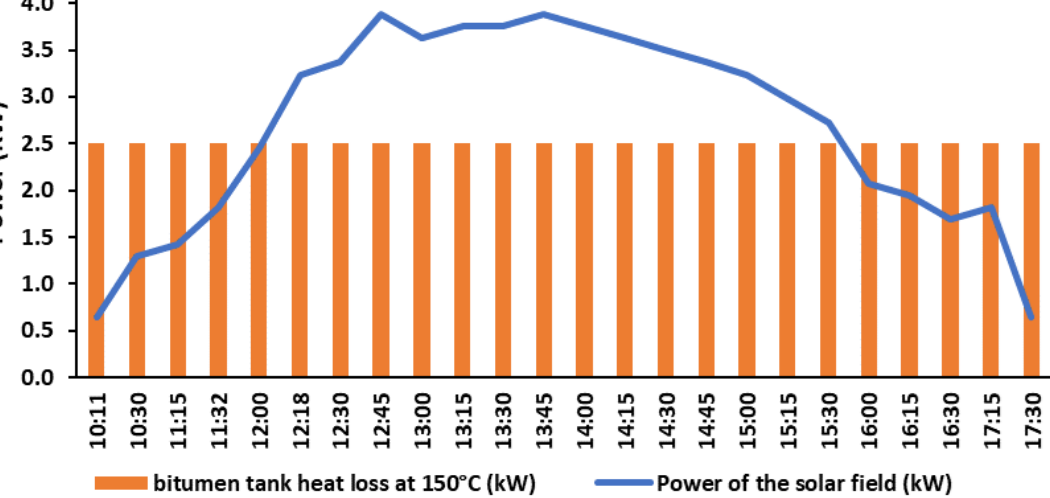
Figure 9. Evolution of temperature upstream and downstream of the XCPC solar field for one day.